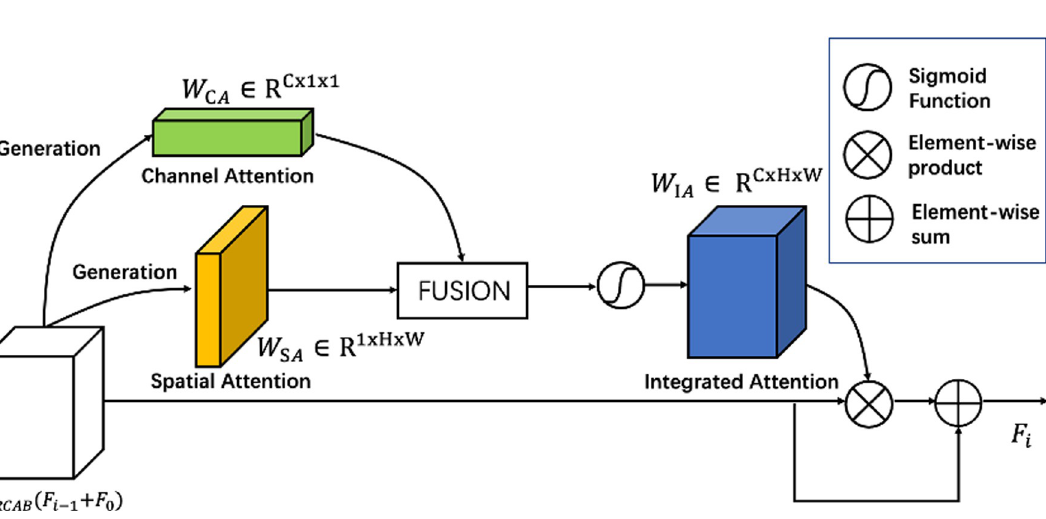
Fig 3. The structure of the proposed integrated attention